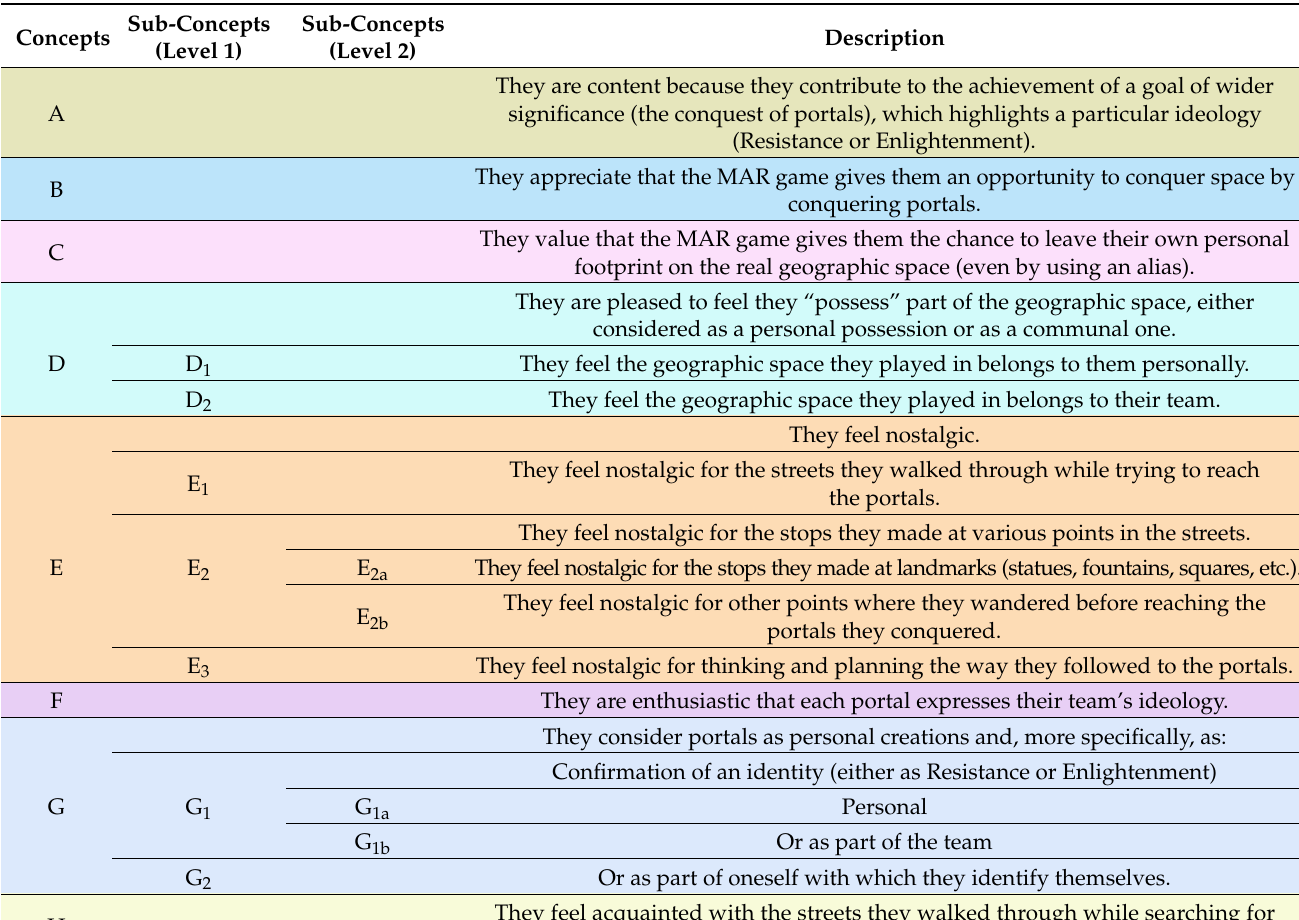
Table 2. Table showing the concepts and sub-concepts of Q 1